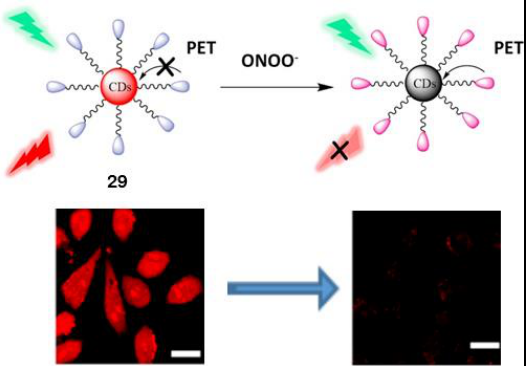
Figure 28. Principle of the ONOO − nanoprobe 29 based on PET. Confocal fluorescence imaging of MCF-7 cells incubated with the nanoprobe 29 (50 μg/mL) and then treated with LPS (1 μg/mL) and IFN- γ (100 ng/mL). The fluorescence emission is collected from 555 to 780 nm. Scale bars 25 µm. Adapted with permission from [101]. Copyright (2017) Elsevier.